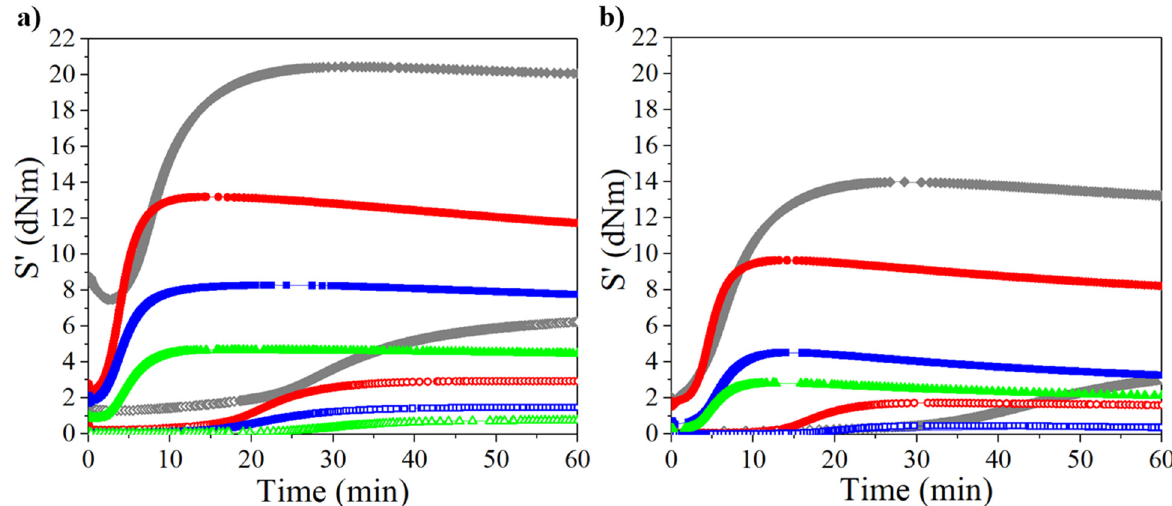
Figure 3. Rheometric curves for crosslinked rubbers through EV at 160 °C for high- ( a ) and low- molecular-weight ( b ) rubbers (open and filled symbols represent unreinforced and reinforced rubbers, respectively). Legend: diamonds PB, circles PI, squares PM, triangles PF.